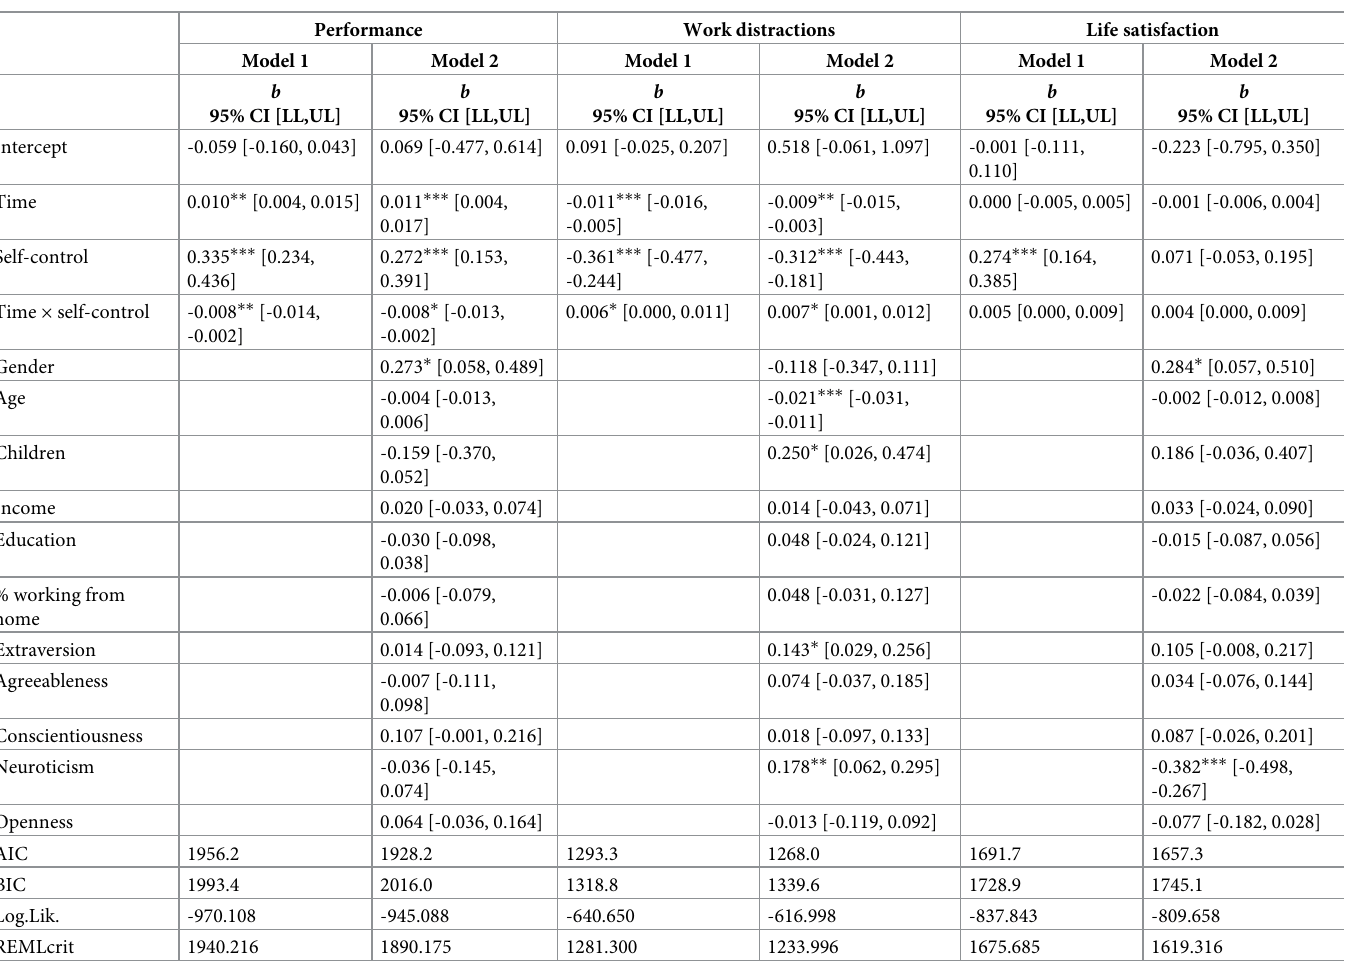
Table 4. Effect of time on worker outcomes as a function of baseline